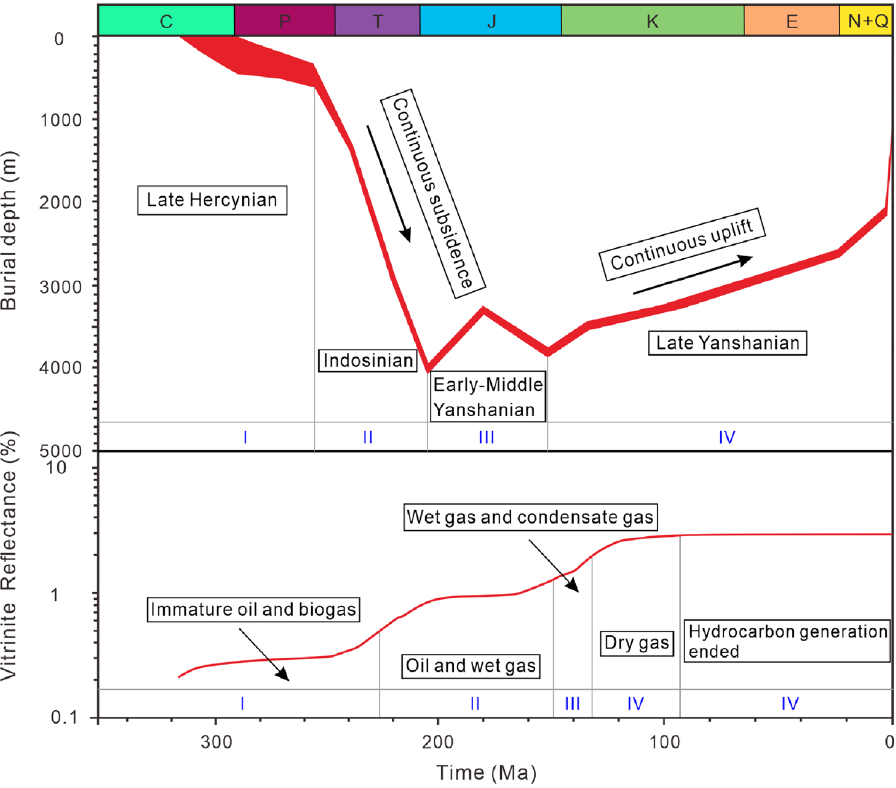
Figure 2. Sedimentary burial and hydrocarbon generation history of the Taiyuan Formation in the study